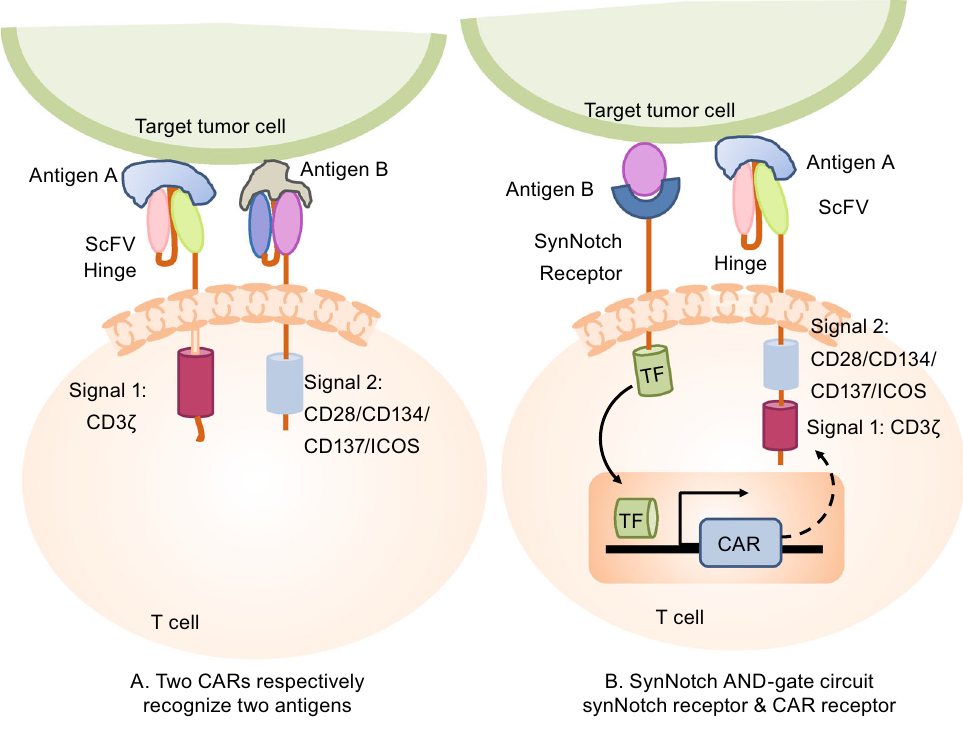
Figure 2. Antigen A AND antigen B combinatorial antigen recognition to optimize the speci fi city of CAR T recognition and reduce the “ on-target/off-tumor ” toxicity. (A) Two-CAR design strategy: one CAR molecule for activation and another CAR molecule for costimulation in the same T cell. (B) SynNotch AND-gate circuit strategy: the synNotch receptor recognizes antigen B fi rst, then inducestheexpressionofCARreceptor,whichrecognizesantigenA,and fi nallyactivatestheTcell.SynNotch,syntheticNotchreceptor, which recognizes a target antigen B, then cleaves the receptor to release a transcriptional activator domain to enter the nucleus and induce the expression of CAR; ScFv, single chain variable fragment; ICOS, inducible Tcell costimulator; TM,